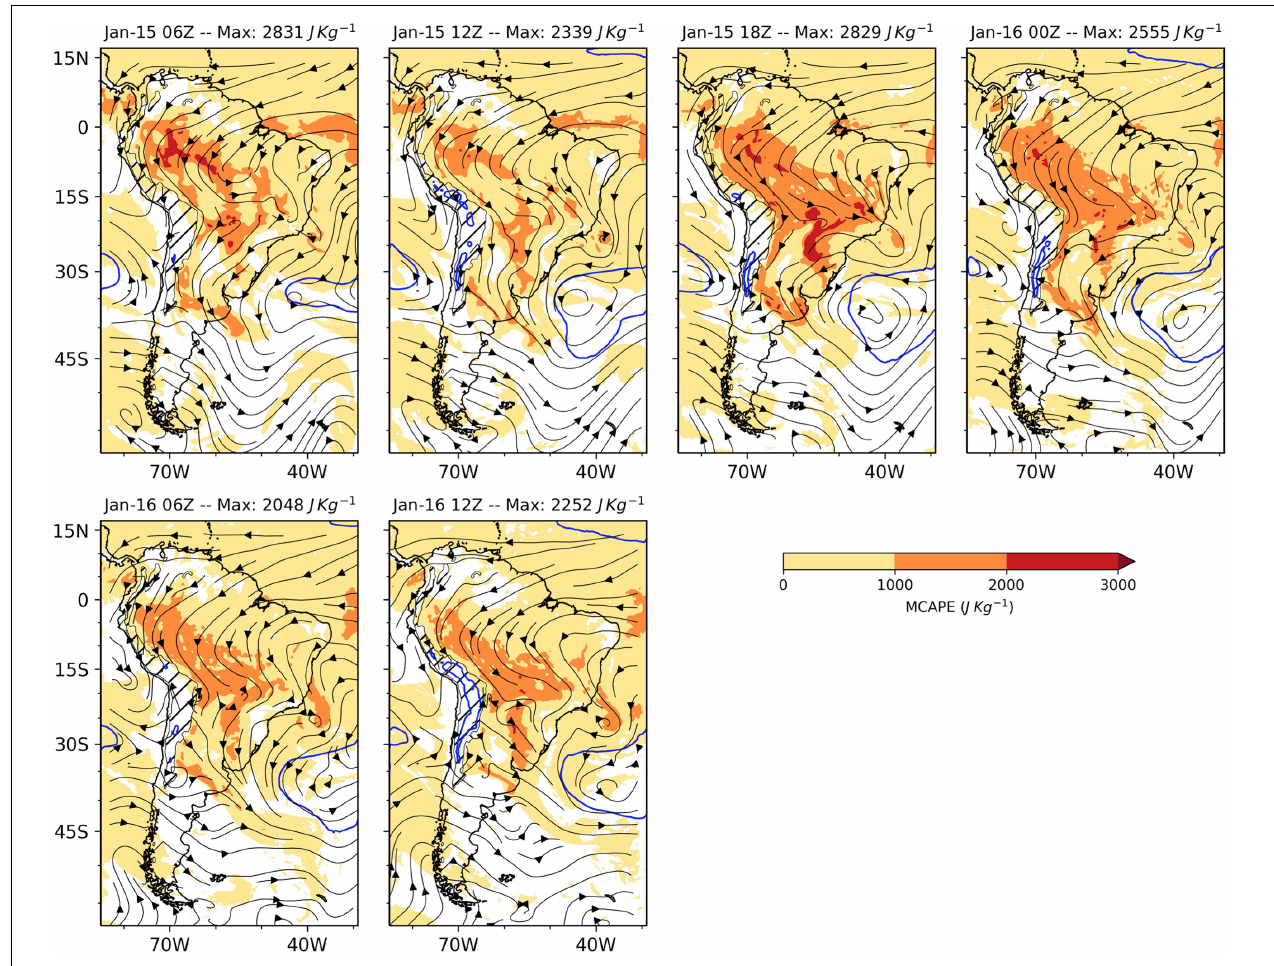
FIGURE 2 | WRF simulation (D01, 18 km) of the WLLJ case during January 15 00Z to 16 12 Z, 2003. The maps show the evolution of the MCAPE in the lower 3,000 m during the simulation. The streamlines show the 850 hPa horizontal wind and the blue contour delineate the 1,020 hPa sea level pressure.